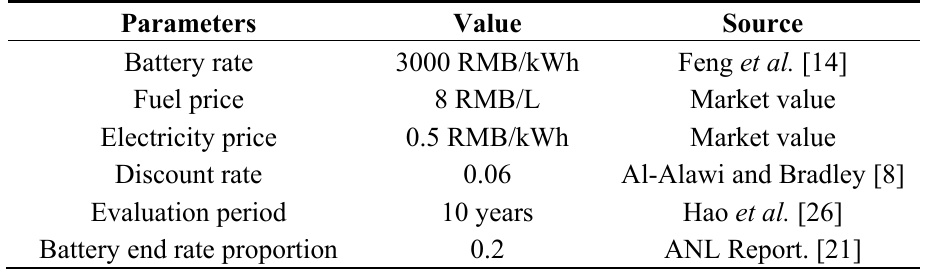
Table 1. Parameters for baseline scenario.